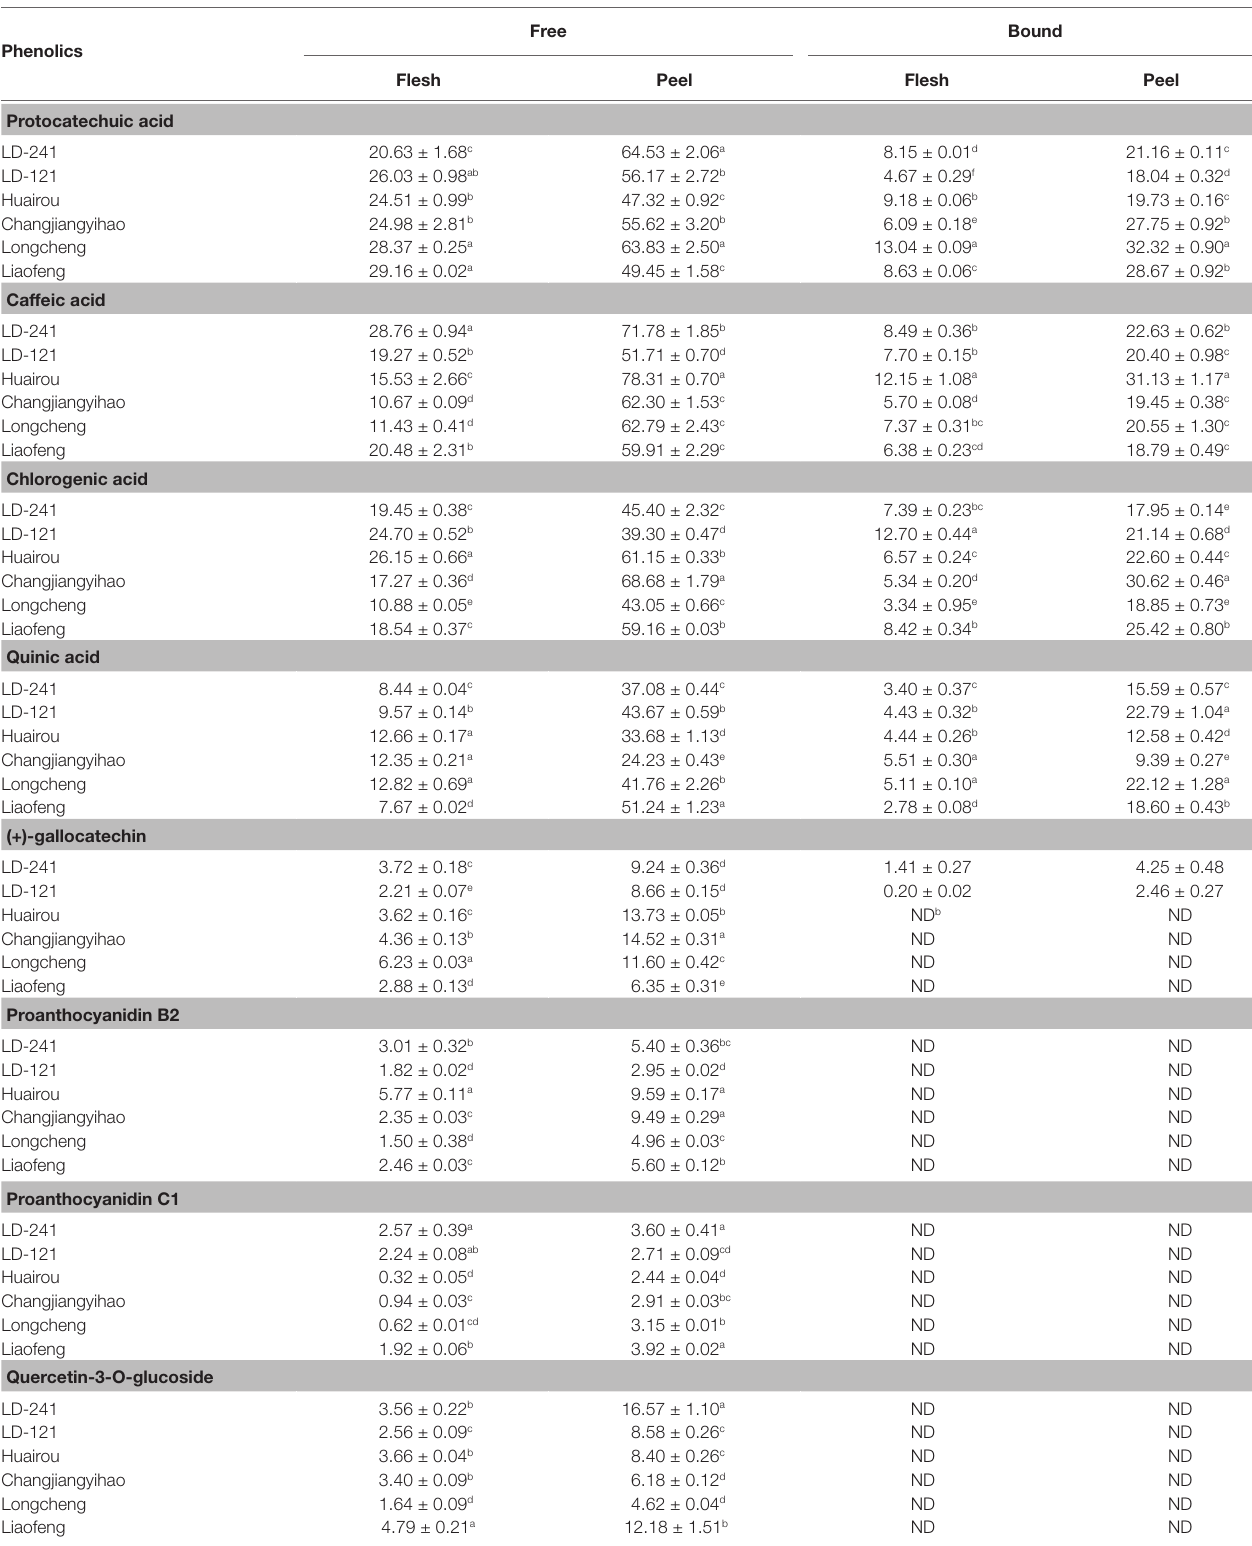
TABLE 3 | Phenolic compositions of different parts of six kiwi berry varieties a ( μ g/g FW). Free Bound Phenolics Flesh Peel Flesh